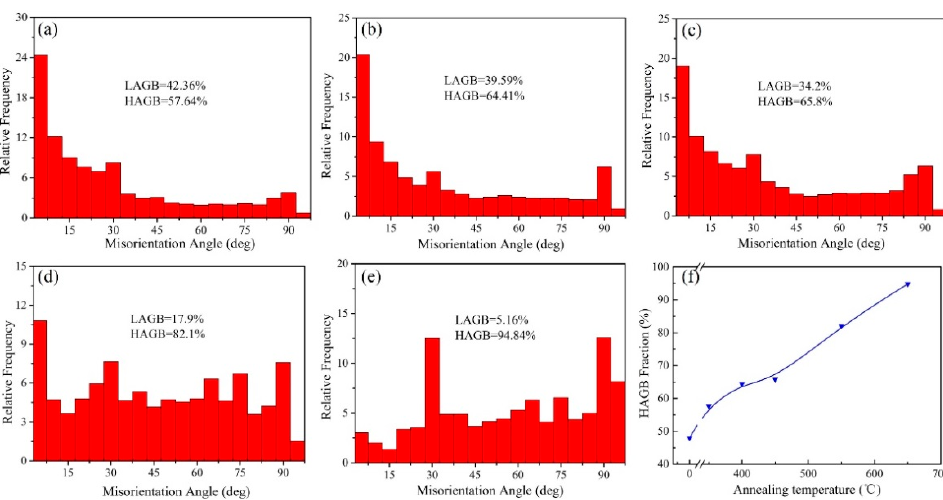
Figure 6. Misorientation angle distributions of the UFG TiFeB alloy after annealing for 1 h at differ- ent annealing temperatures of ( a ) 350 °C, ( b ) 400 °C, ( c ) 450 °C, ( d ) 550 °C, and ( e ) 650 °C. ( f ) The annealing temperatures of ( a ) 350 ◦ C, ( b ) 400 ◦ C, ( c ) 450 ◦ C, ( d ) 550 ◦ C, and ( e ) 650 ◦ C. ( f ) The curve curve of HAGB variation with annealing temperature. of HAGB variation with annealing